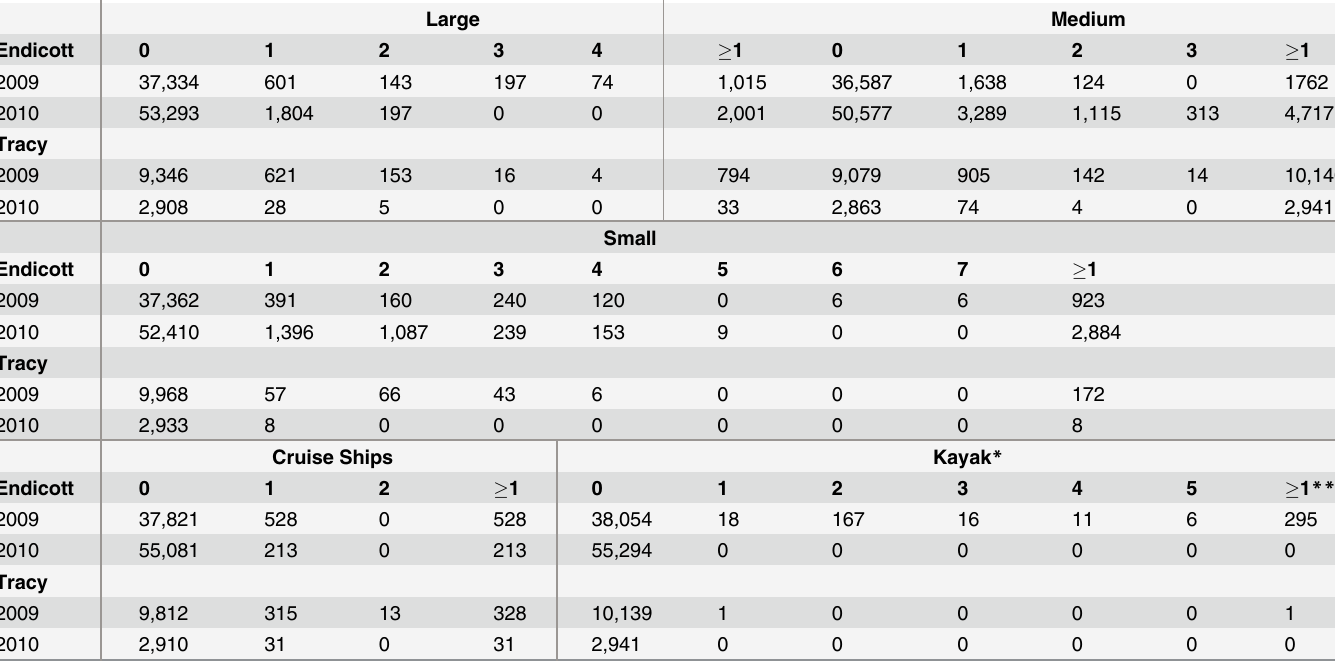
Table 3. Tally of numbers of observations of vessels captured with cameras by vessel category, inlet, and year. Large